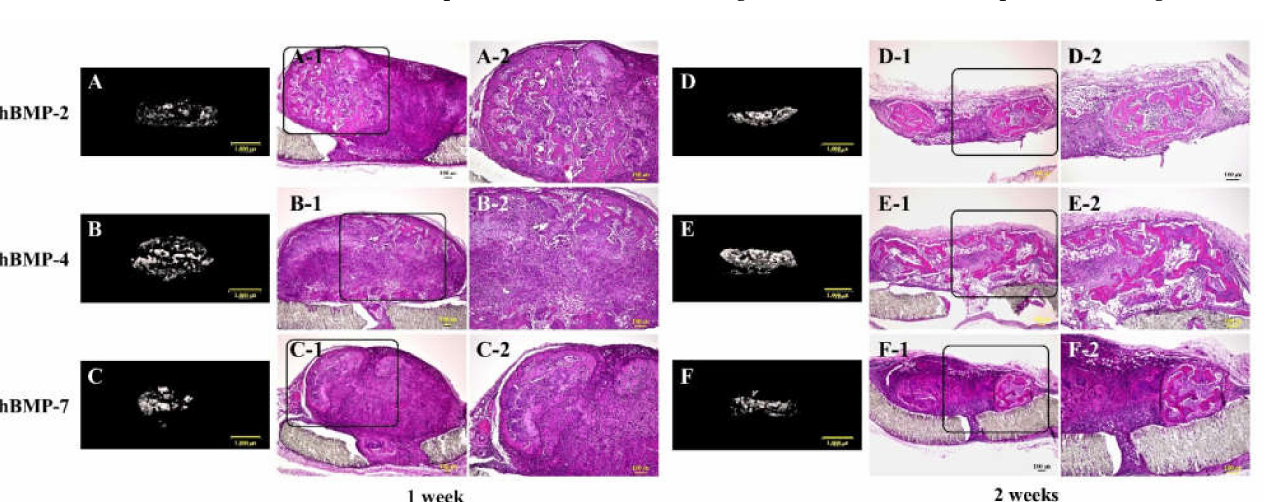
Figure 5. Typical micro-CT ( A – C and D – F ) and histological images of each subcutaneously implanted rhBMP-2, rhBMP-4, and rhBMP-7 sample into the backs of rats at one and two weeks. A-2, B-2, and C-2 are magnified insert images of A-1, B-1, and C-1, and D-2, E-2, and F-2 are magnified insert images of D-1, E-1, and F-1, respectively. Scale bar sizes in micro-CT and histological images are 1000 µ m and 100 µ m,